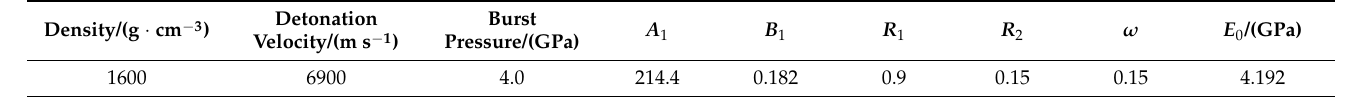
Table 1. Explosive and its equation of state